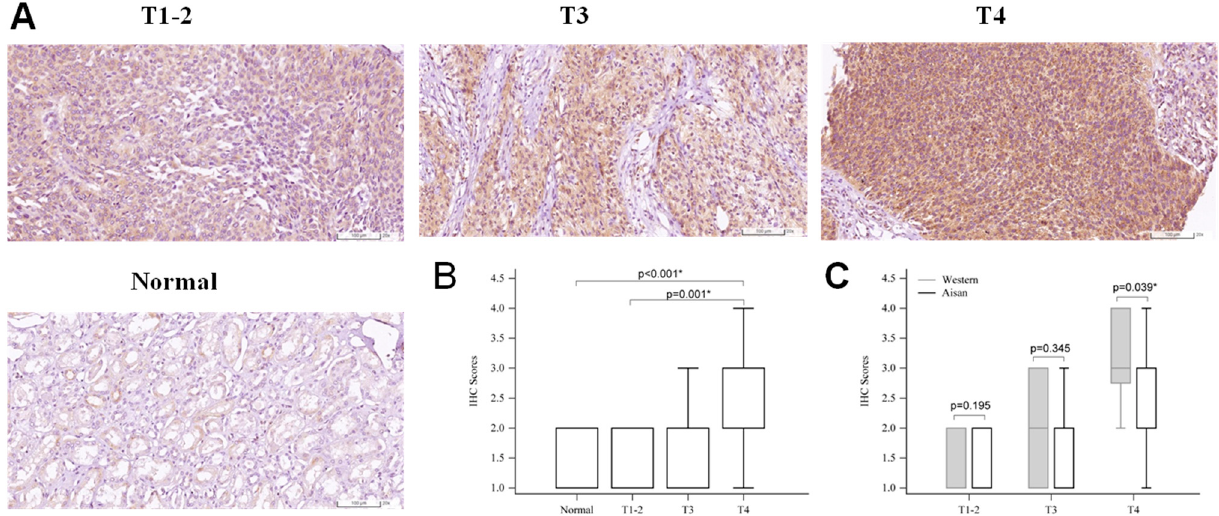
Figure 2. Up-regulation of FGFR3 in renal pelvis tissues from Asian patients with upper tract urothelial carcinoma (UTUC). Renal pelvis tissues were collected from Asian patients diagnosed with UTUC at different TNM stages, including T1–2 ( n = 44), T3 ( n = 38), and T4 ( n = 30). The formalin-fixed paraffin-embedded sections were subjected to immunohistochemistry (IHC) analysis of FGFR3 expression. ( A ) Representative FGFR3-positive stained images from stages T1–2, T3, and T4 and that of archived normal kidney pelvis tissues. ( B ) Analysis of FGFR3 IHC scoring results. ( C ) Statistical analysis of ethnic difference in FGFR3 expression at different UTUC stages. Data are shown in box plots displaying 25% to 75% percentiles. * indicates significance between the indicated groups. Table 2. FGFR3 positivity rates in renal pelvis tissues from Asian patients with upper tract urothelial carcinoma (UTUC).